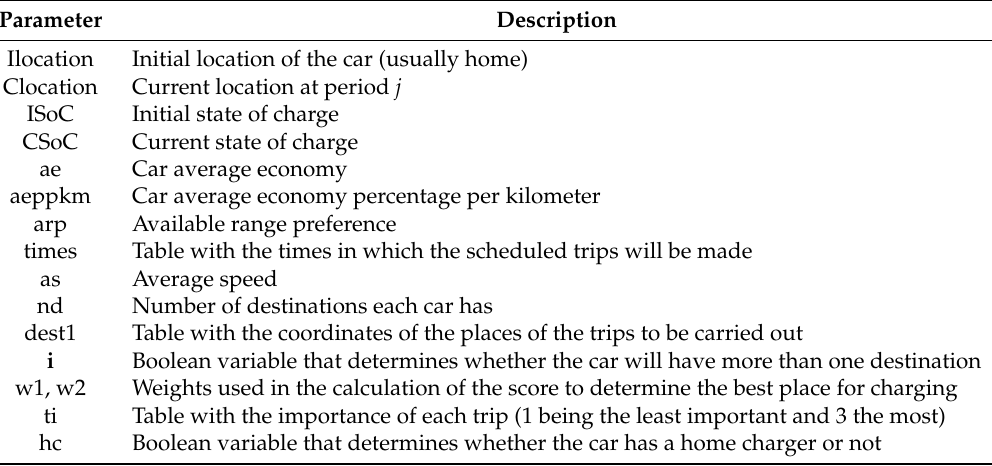
Table 2. User profile